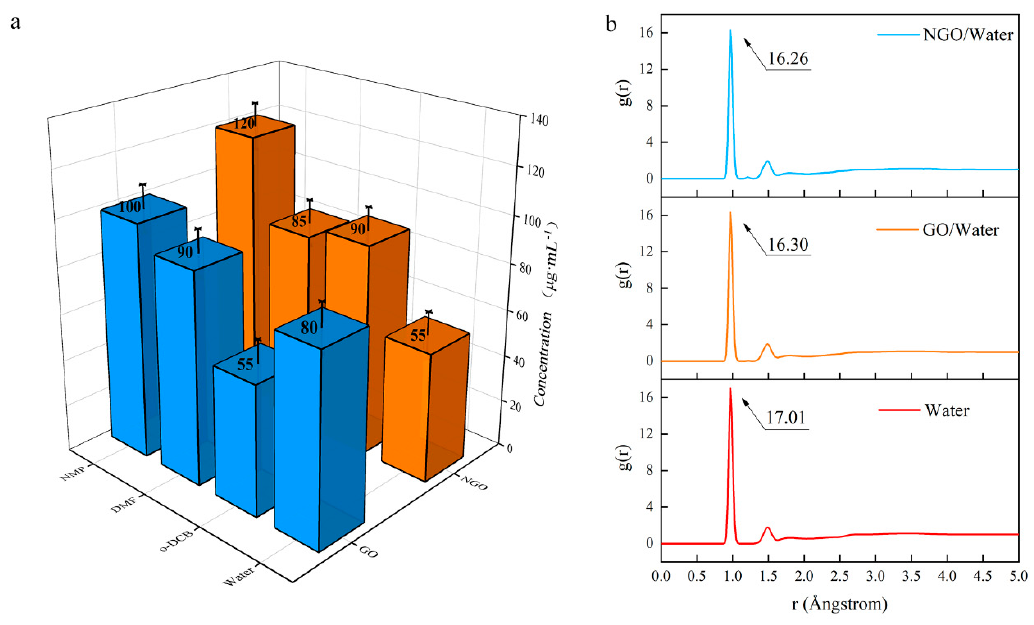
Figure 6. ( a ) The concentration of GO and NGO in different solvents; ( b ) The radial distribution function (RDF) diagram of water, GO/water system and NGO/water system.